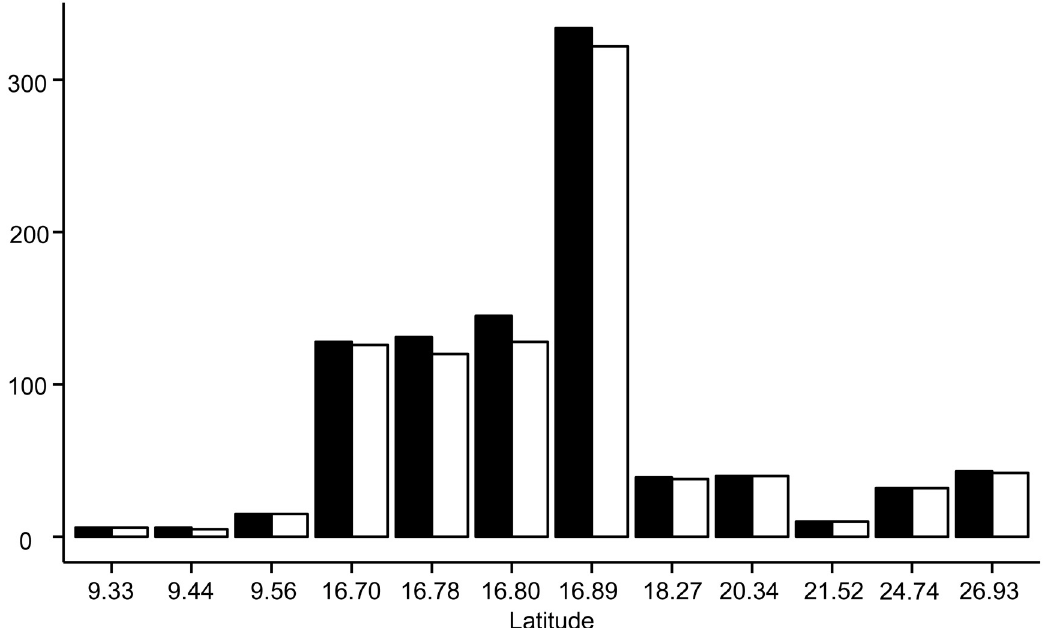
Fig 3. Abundance of all endoparasites, and Lecithochirium floridense in P . volitans by latitude. Black bars represent endoparasite abundance (total number of parasites in infected and uninfected hosts), while white bars represent abundance of L . floridense . Latitude increases from left to right, and all sites, except for the outlying back reef site in Galeta Point, are shown. Sample sizes (hosts examined) at each site ranged from 17 – 27; see Table 1 for details on collection effort.